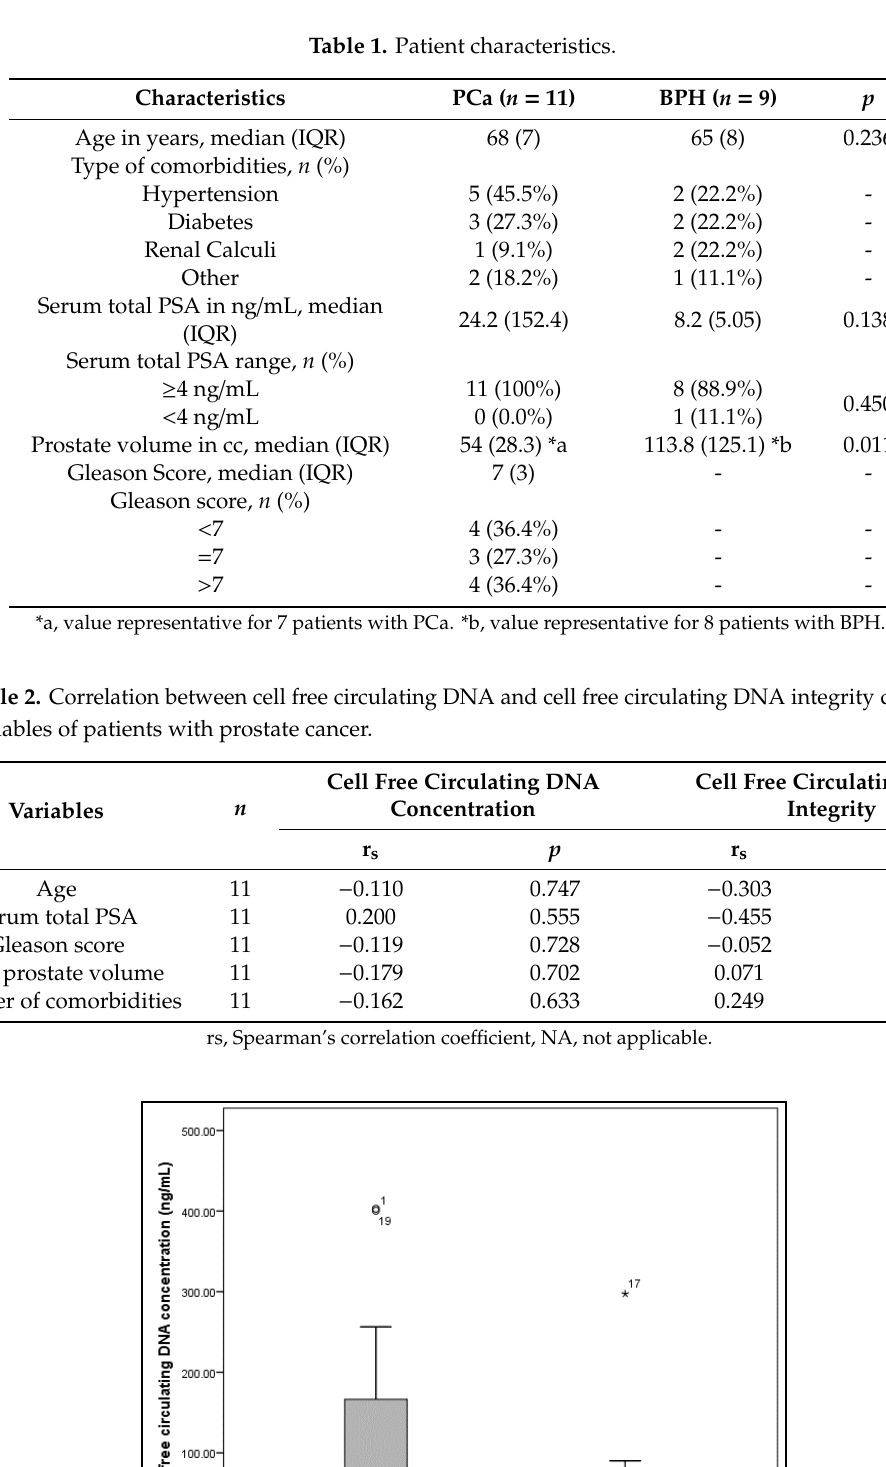
Figure 2. Box plot for the of plasma cell free circulating DNA integrity of prostate cancer and benign prostatic hyperplasia patients. Note that ◦ represents an outliers. There was a weakly positive correlation between cfcDNA concentration and serum total PSA (r = 0.200, p = 0.555) but not with other clinicopathological parameters such as age and Gleason score in